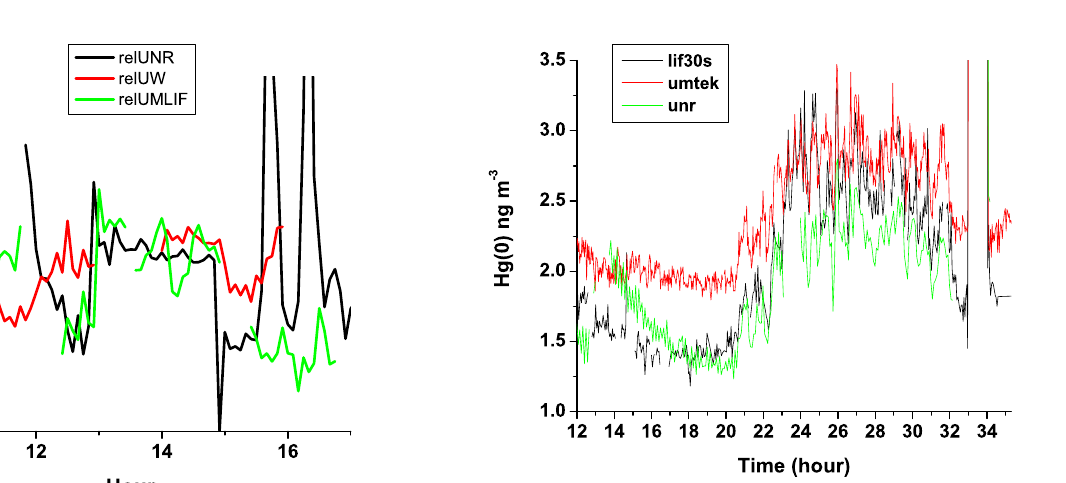
Figure 3. A 7h measurement period from 5 September. The per- cent difference of the UNR (black line) and UW (red line) Tekrans and the UM 2P-LIF (green line) measurements relative to the UM Tekran is shown.